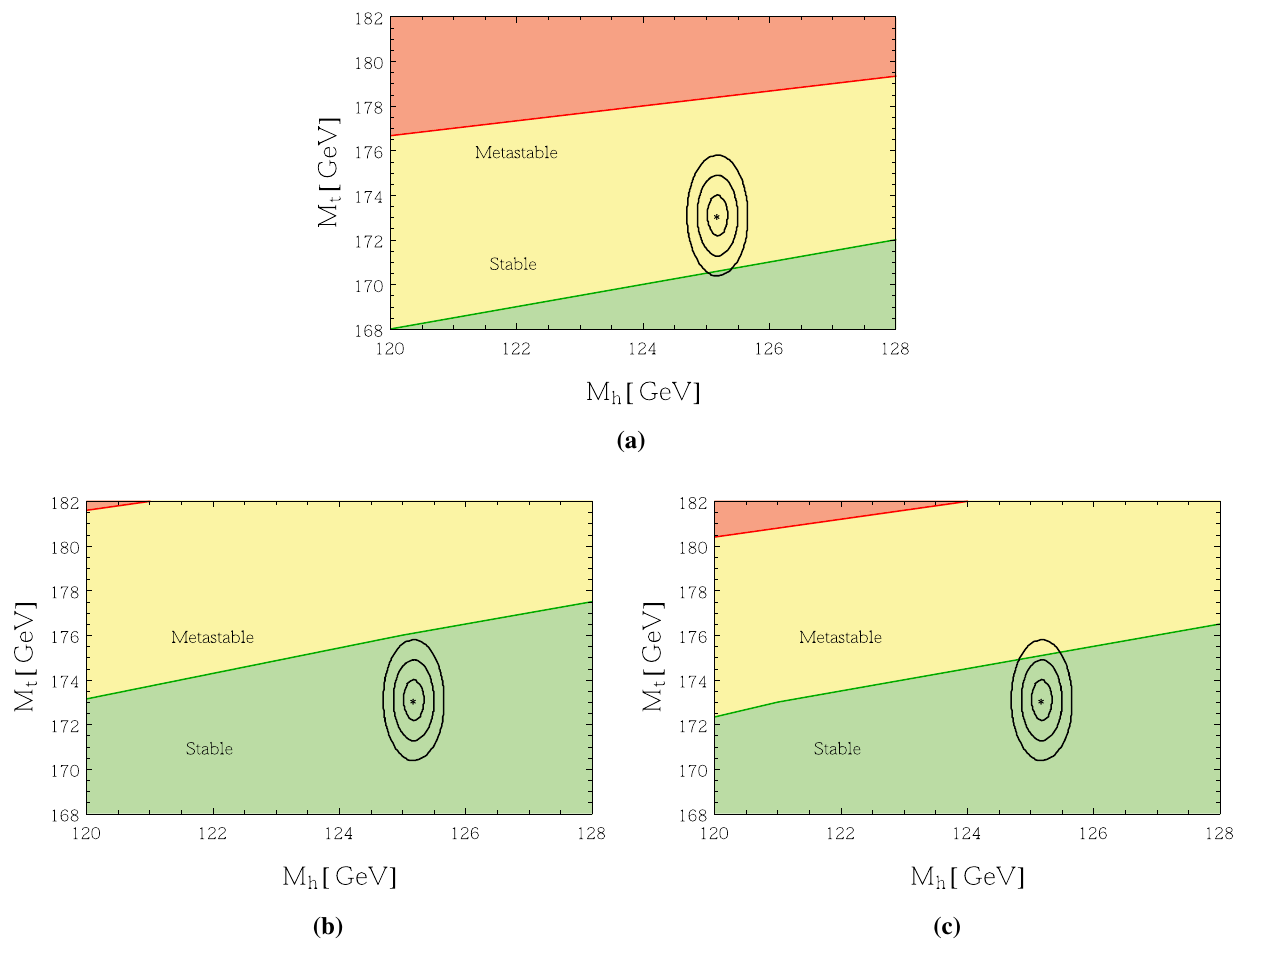
Fig. 7 Phase diagram in terms of Higgs and top pole masses in GeV for a SM like scenario, b inert Higgs Doublet Model and b inert Higgs TripletModel.Theredcolourcorrespondstotheunstableregion,yellow